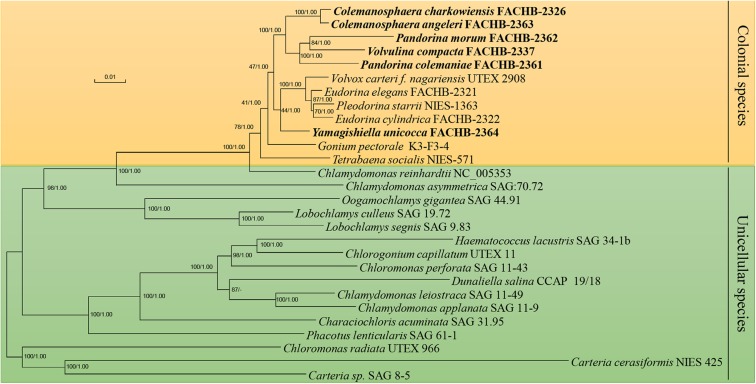
Phylogenetic tree of the Chlamydomonadales species based on the 55 chloroplast genes. Numbers on the left and right side at the branches represent bootstrap values and Bayesian posterior probabilities, respectively. Scale bar indicates substitutions per site. Our strains were shown in bold. The orange background indicated the colonial volvocine algae, and the green background indicated the unicellular species.